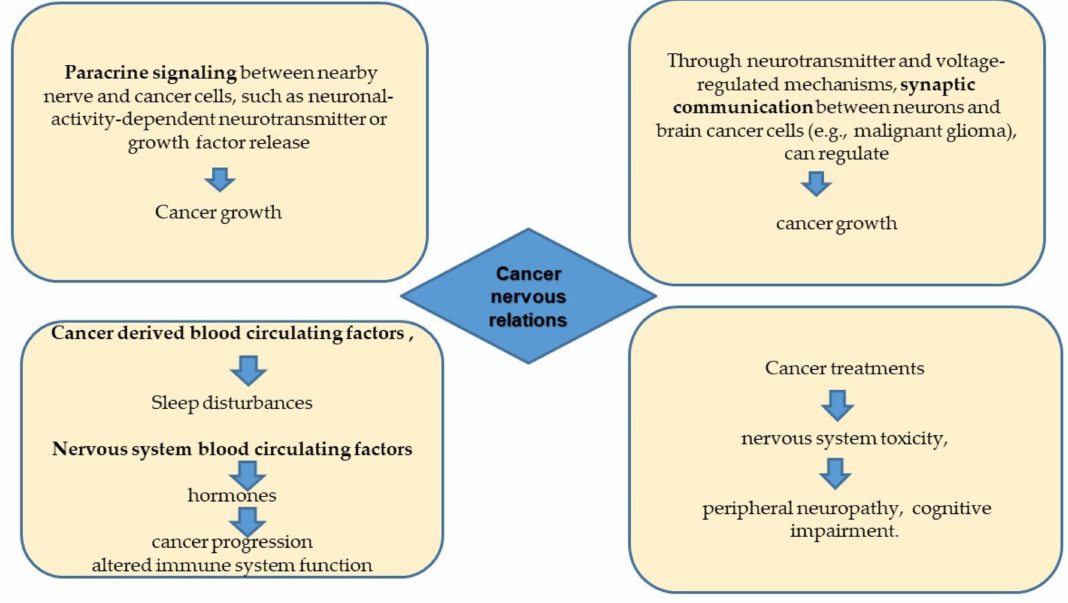
Figure 1. The four main areas of cancer/nervous system